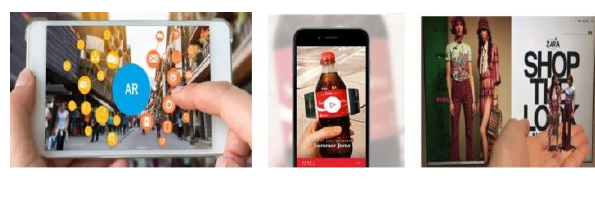
Fig. 6. AR Marketing